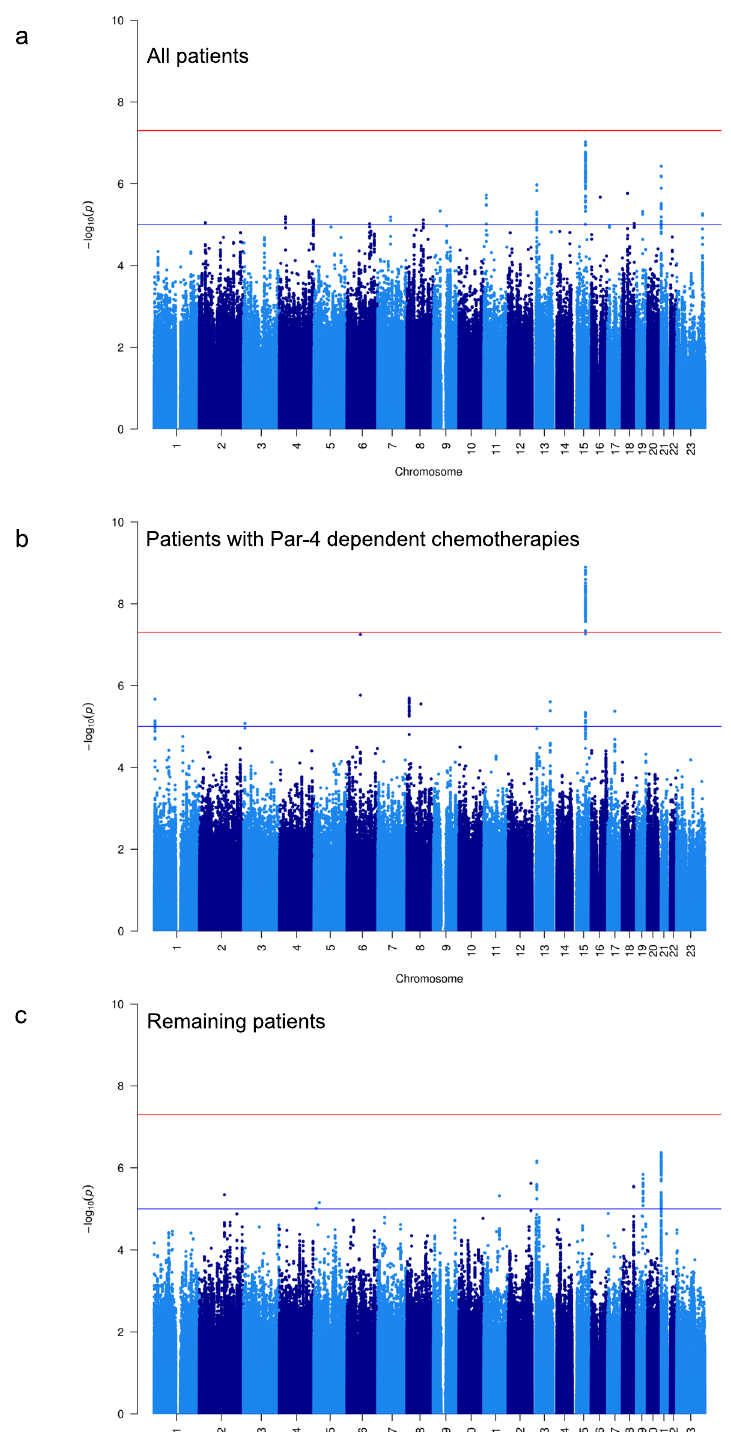
Fig. 1 Manhattan plot for trans-ethnic meta-GWAS of OS in the Pathways Study. Analysis included all patients ( a ), patients taking Par-4 dependent chemotherapies ( b ), and the remaining patients ( c )